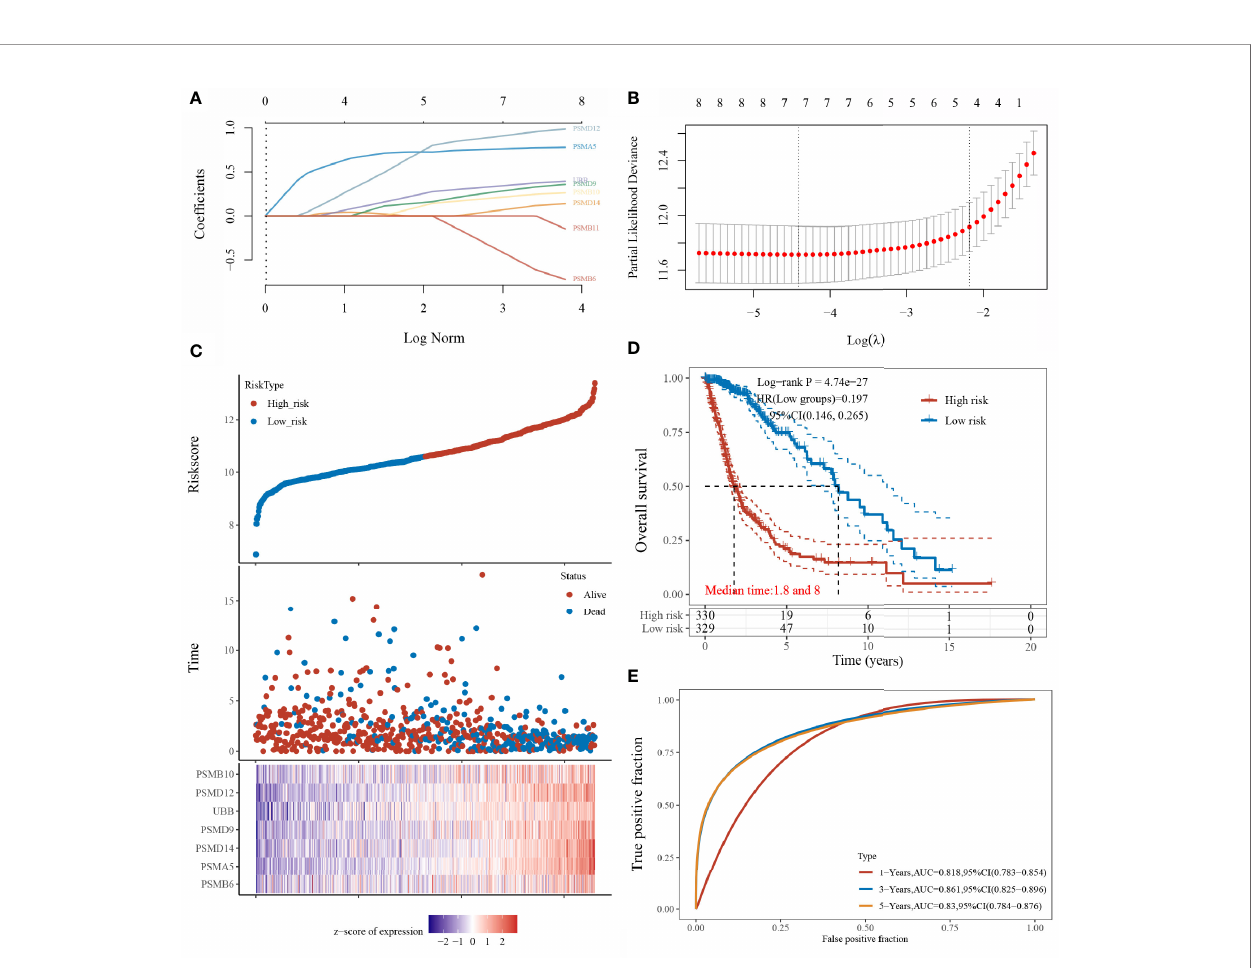
FIGURE 5 | Construction of the LASSO prognostic model. (A) Coef fi cients of selected features shown by lambda parameters; (B) partial likelihood deviation plotted against log( l ) using LASSO-Cox regression model; (C) risk score and survival time with survival status pro fi le and expression levels of the seven gene signatures; (D) Kaplan – Meier curves for patients in the high- and low-risk groups; and (E) ROC curve validation (LASSO model for 1-, 3-, and 5-year prediction accuracies).